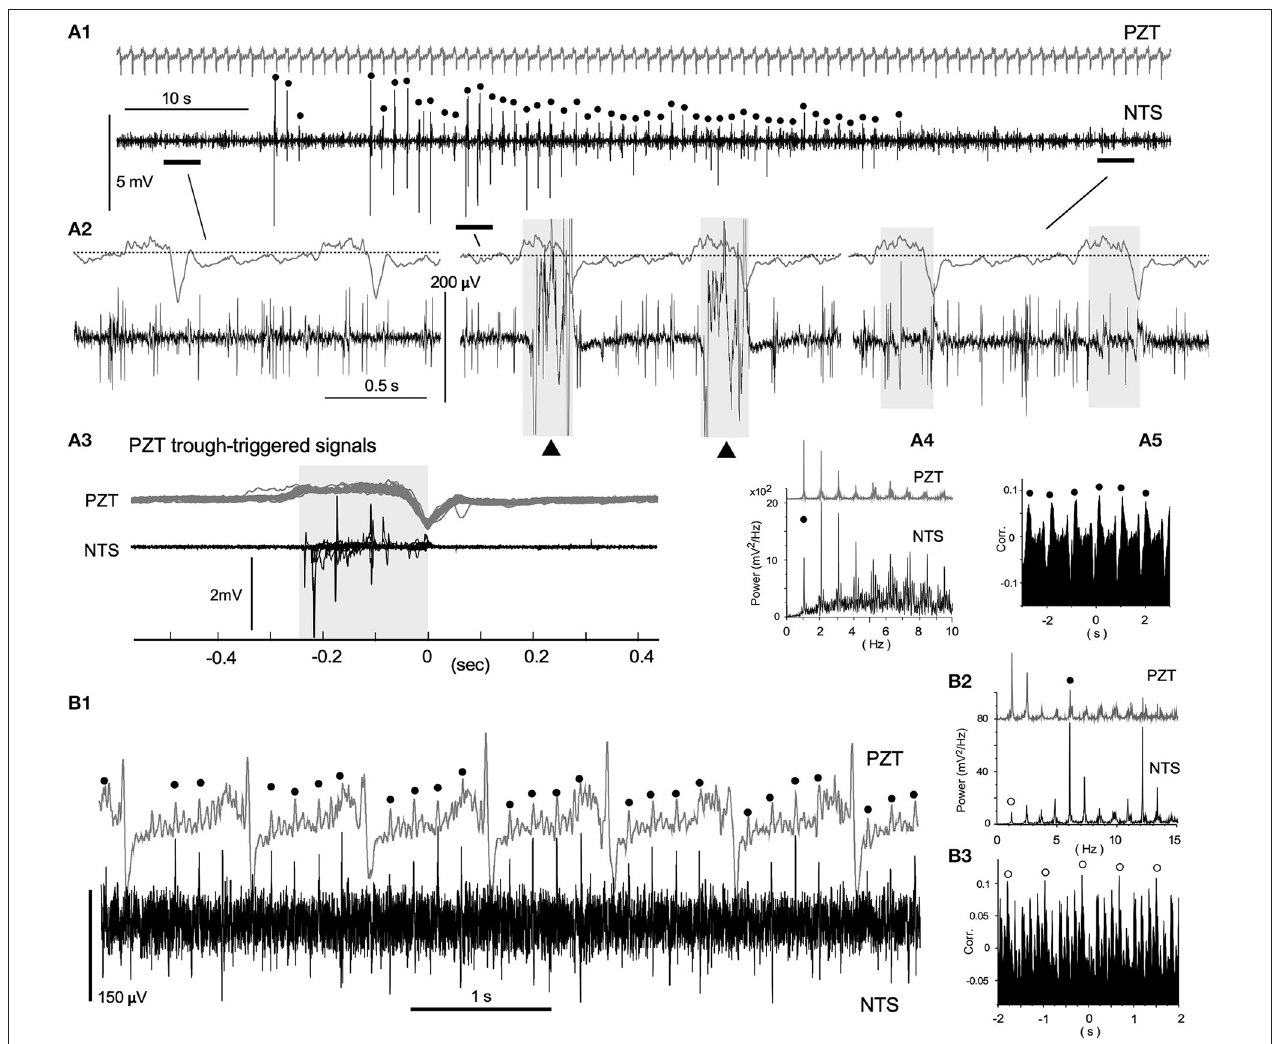
FIGURE 3 | Neuronal activities synchronized with cardiorespiratory cycles, recorded in vivo using a glass electrode. (A1) Episodic emergence of trains of high-amplitude potentials are synchronized with the respiratory cycle. PZT traces ( A1–3 ; shown in gray) exhibit a respiratory cycle of 1.1Hz and a heartbeat cycle of ∼ 5.6Hz. Trains of high-amplitude potentials synchronized with respiratory cycles are marked with solid dots. Three episodes of a 3–4s duration before, during, and ∼ after the high-amplitude potential trains, corresponding to horizontal bars in (A1) are shown in (A2) with simultaneously-recorded PZT traces. High-amplitude potential traces in the middle are truncated. Note the polyphasic high-amplitude potentials (solid triangles) synchronized with the inspiration phase (gray-shaded). The last episode contains low-amplitude and longer-duration signals during the inspiration phase (gray-shaded) in addition to short-duration spikes. (A3) PZT-trough-triggered high-amplitude potentials of 20 successive respiratory cycles. Multiple potentials appear during the inspiration phase (gray-shaded). (A4) and (A5) Power-spectrum analyses (Power) and a correlogram (Corr.) of neuronal and cardiorespiratory (PZT: gray in A4 ) activities are shown. Respiratory peaks of 1Hz are marked with solid ∼ circles. (B1) Low-amplitude spikes synchronized with heartbeat cycles. A simultaneous in vivo recording of neuronal and cardiorespiratory (in gray) activities indicate synchrony of short-duration spikes of 100 µ V amplitude with heartbeat cycles of 5.9Hz (solid circles). (B2) and (B3) , Power-spectrum analyses (Power) and a ∼ ∼ correlogram (Corr.) of neuronal and cardiorespiratory (PZT: gray in B2 ) activities. Heartbeat and respiratory peaks are marked with solid and open circles, respectively. NTS, the nucleus tractus